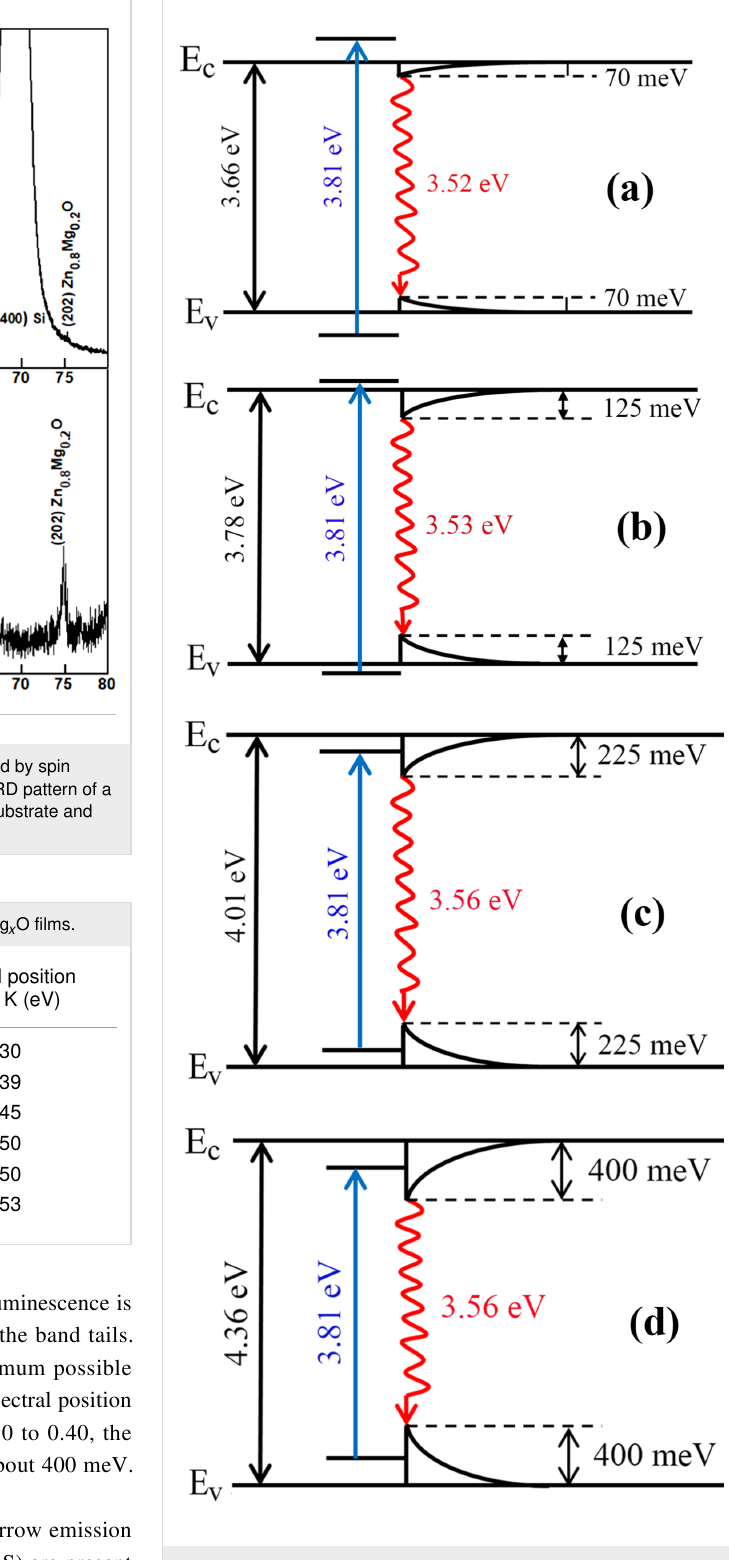
Figure 7: A model for the band tails distribution at 20 K in Zn 1 − x Mg x O films with the x value composition of a) 0.10; b) 0.15; c) 0.25 and d)